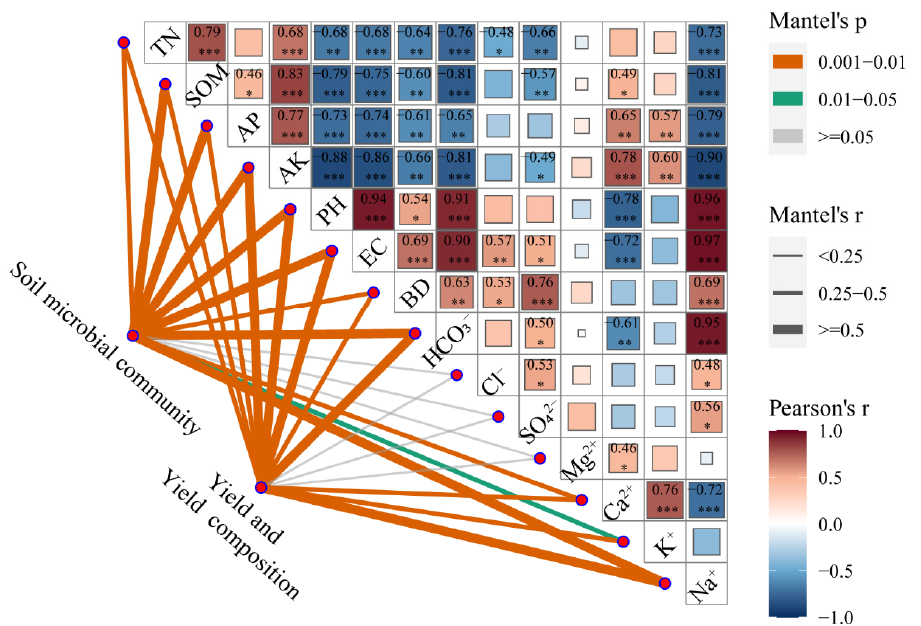
Figure 1. Mantel analysis of the soil microbial structure, grain yield, and yield components in response to environmental factors. The labels indicate significant levels tested by Pearson correlation (* p < 0.05, ** p < 0.01, *** p < 0.001).